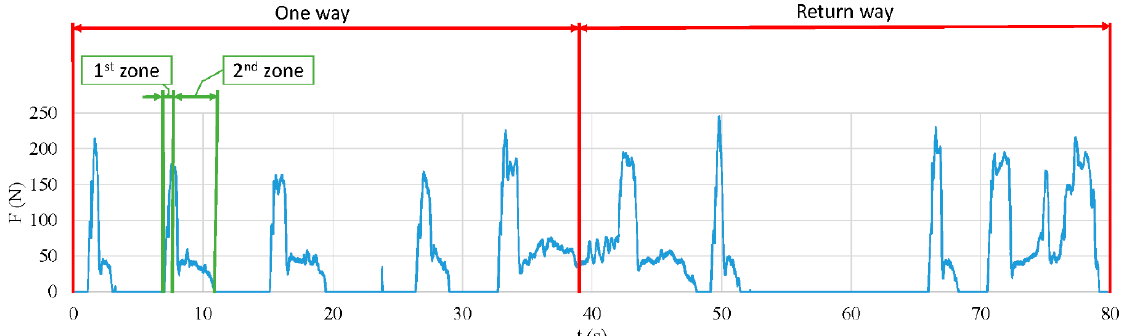
Figure 6. Force applied on the clutch pedal during a complete driving test. The red lines separate the curves belonging to the one way or return way direction. The green lines indicate one gear change distinguishing between the first zone (disengaging) and the second zone (engaging).